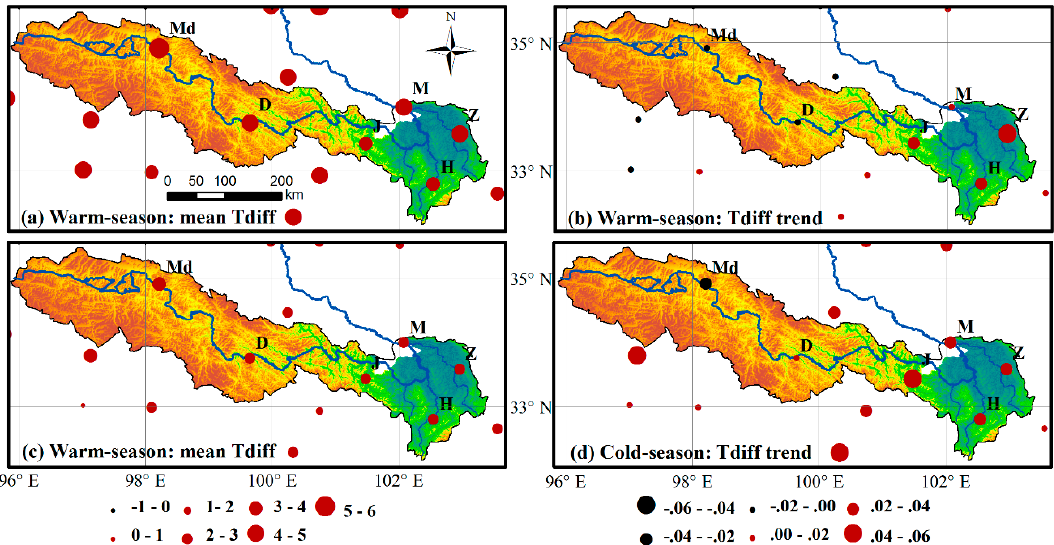
Figure 7. The means (°C) and trends (°C·year − 1 ) of the surface air-ground vertical temperature difference (Tdiff) based on in-situ weather station measurements during the 1985–2007 period: ( a , b ) warm-season (from May to September); and ( c , d ) cold-season (from October to April). Red (black) dots indicate positive (negative) Tdiff mean or trend with the magnitudes proportional to the symbol size. The weather stations used include M (Maqu), Z (Zoige), H (Hongyuan), J (Jiuzhi), D (Dari) and Md (Maduo).